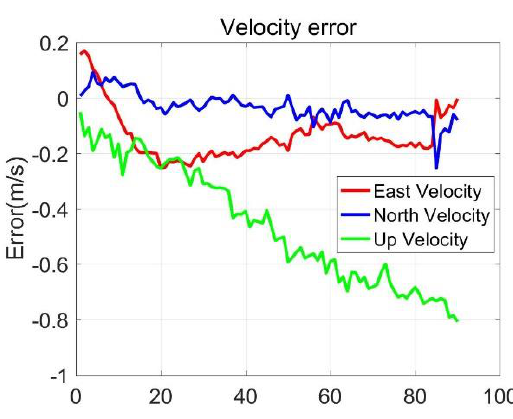
Figure 11. Positioning errors.